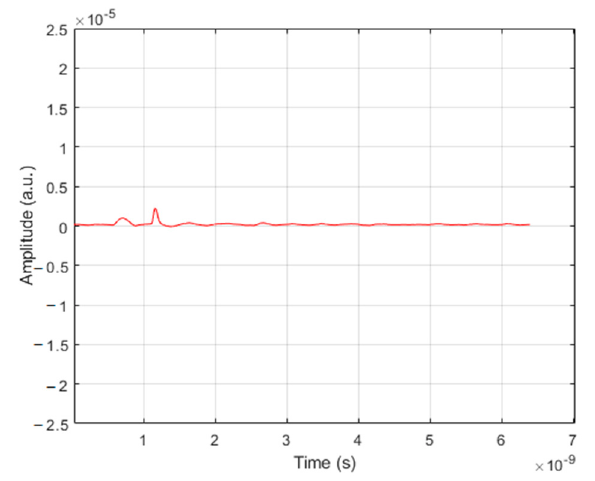
Figure 8. Output spectra before photodetection for the mismatch decoder when bit “0” was transmitted: ( a ) total signals at the upper branch; ( b ) total signals at the lower branch.